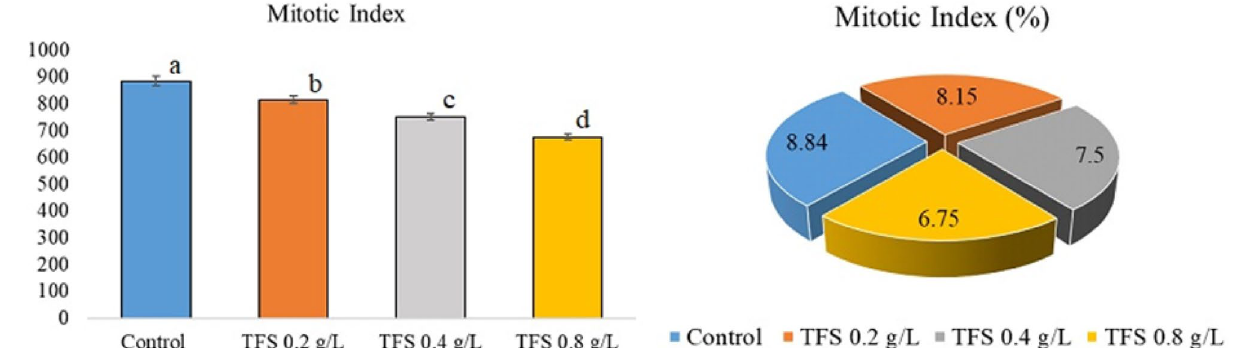
Figure 1. Changes in MI induced by Trifloxystrobin. The averages shown with different letters (a–d) are significantly different at p <